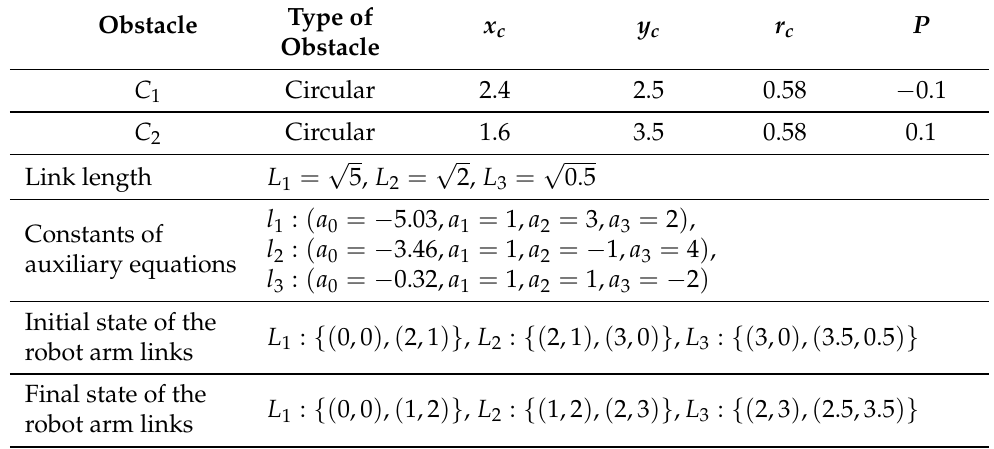
Table 1. Parameters of Case Study